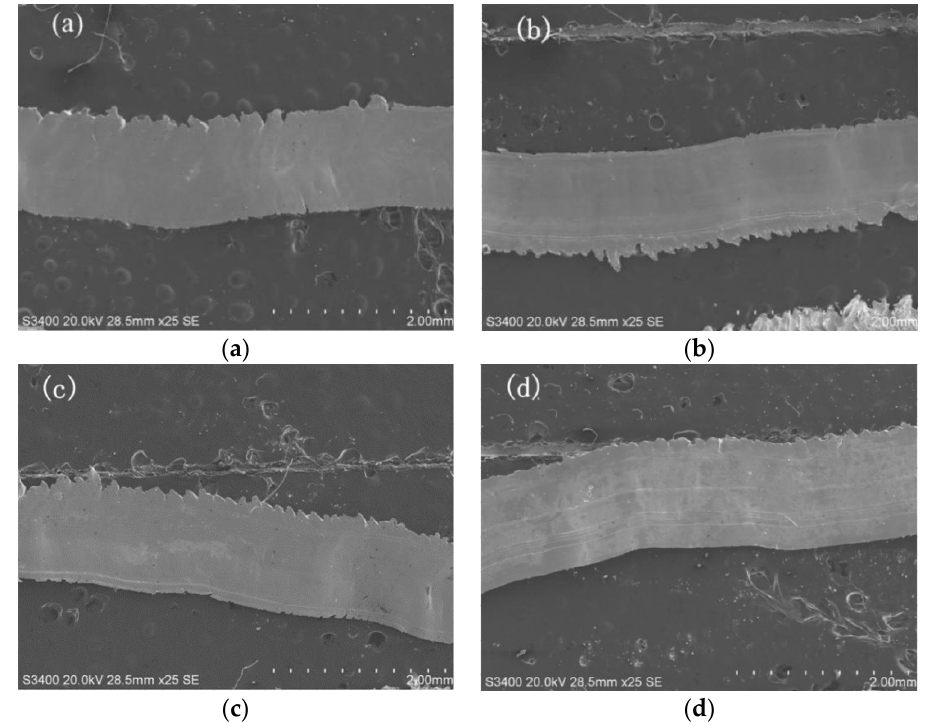
Figure 4. The back surface of the chips produced by the four tools. ( a ) Produced by a non-textured tool; ( b ) Produced by a line textured tool; ( c ) Produced by a sinusoidal textured tool; ( d ) Produced by a rhombic textured tool.